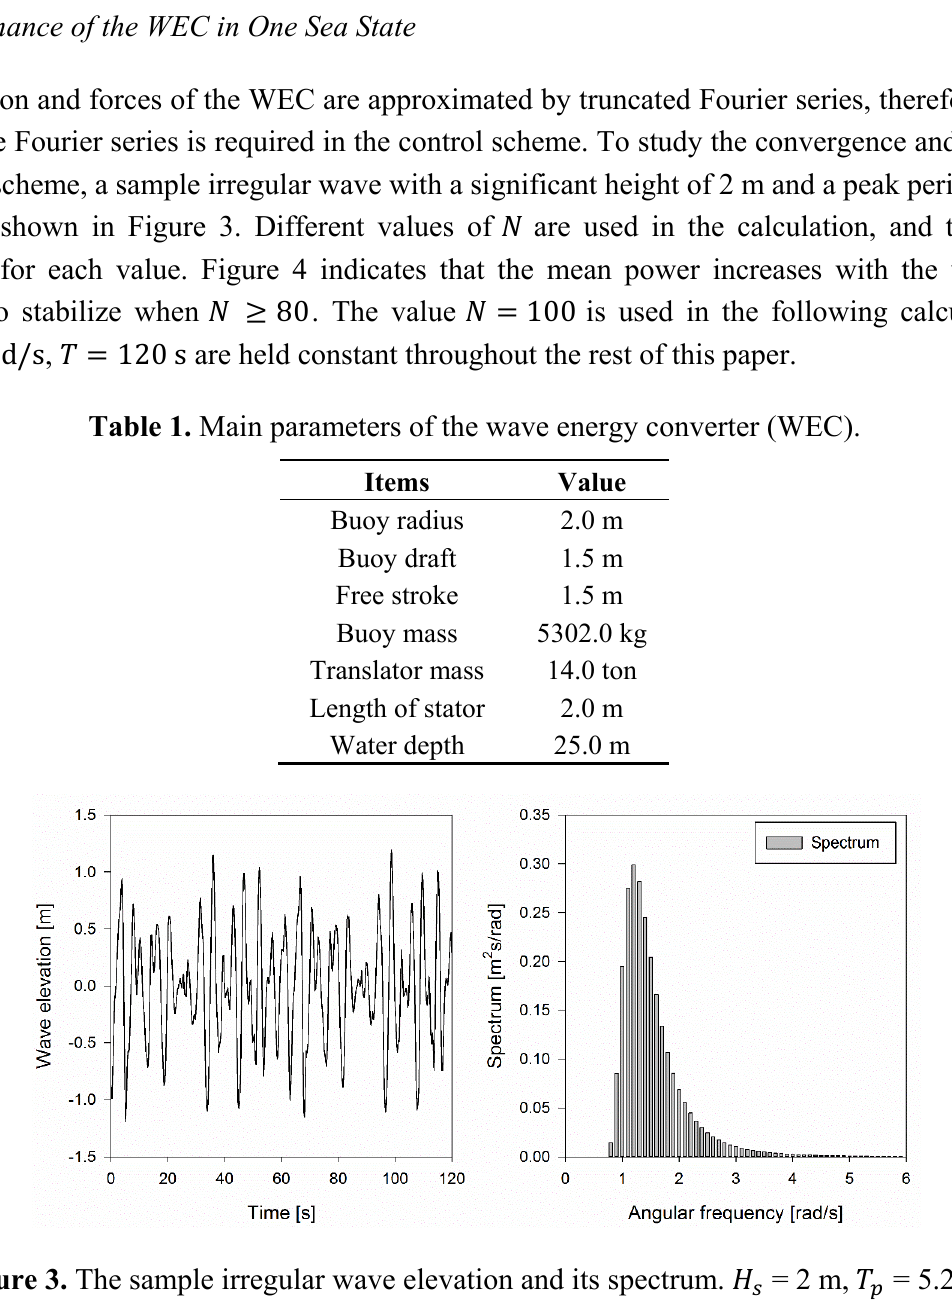
Figure 3. The sample irregular wave elevation and its spectrum. (cid:1834)